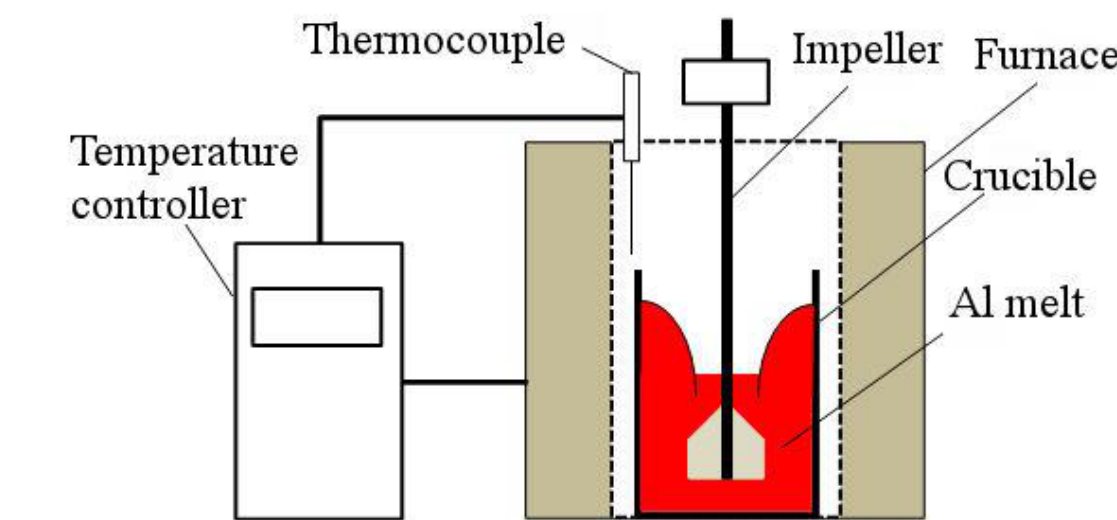
Figure 3. A schematic representation of experimental setup for particle incorporation.